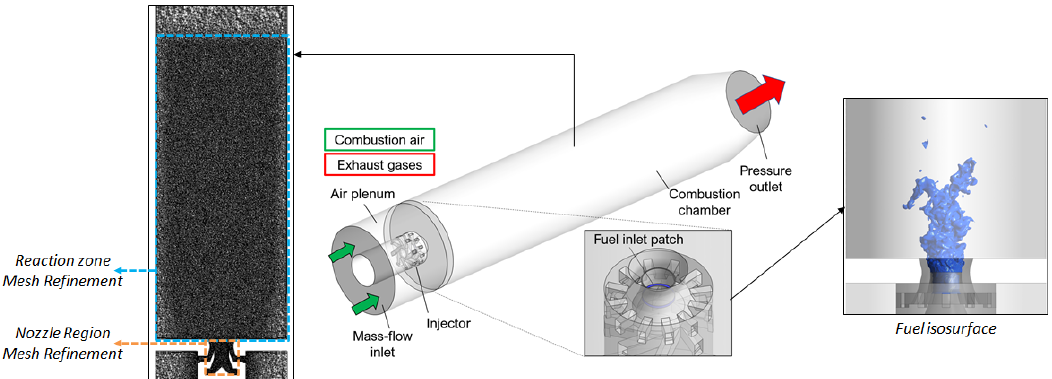
Figure 3. Sketch of the CFD numerical domain with the mesh grid. Blue box: flame tube local mesh refinement. Orange box: swirler local mesh